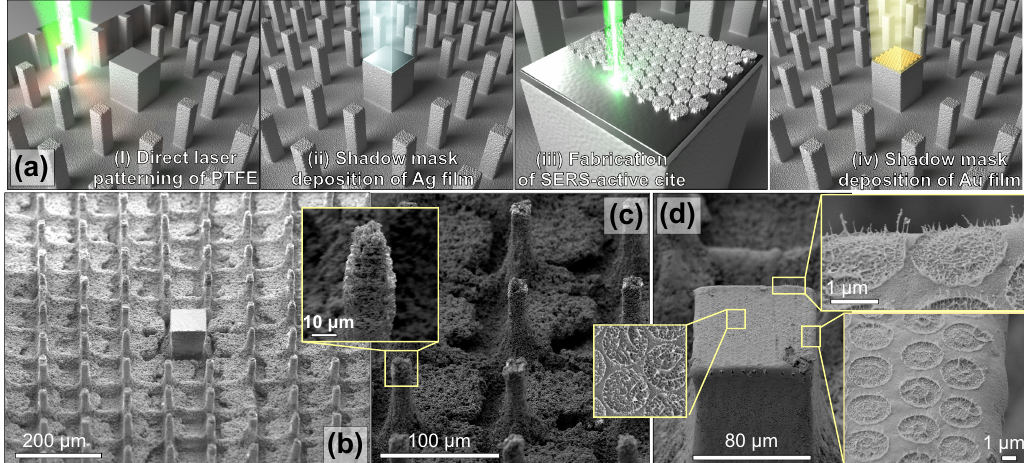
Figure 1. Fabrication of plasmonic sensor with analyte-enrichment system. ( a ) Scheme of the sensor fabrication process: ( i ) direct laser writing of analyte-enrichment system on PTFE surface; ( ii ) deposition of 600-nm thick Ag film onto a central pillar through a shadow mask; ( iii ) fabrication of plasmonic sensor element via direct laser texturing of the central pillar; ( iv ) deposition of 25-nm thick Au film through a shadow mask. ( b ) Side-view (view angle of 40 ◦ ) scanning electron microscopy (SEM) images of the analyte-enrichment system fabricated on PTFE surface. ( c , d ) Close-up SEM images showing details of surface morphology of the hydrophobic pillars and laser-patterned plasmonic